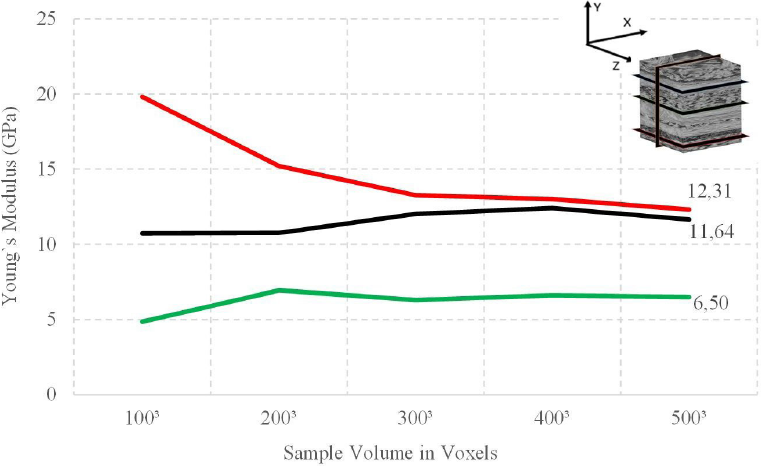
Figure 18. Convergence of effective properties of CSM layer in all